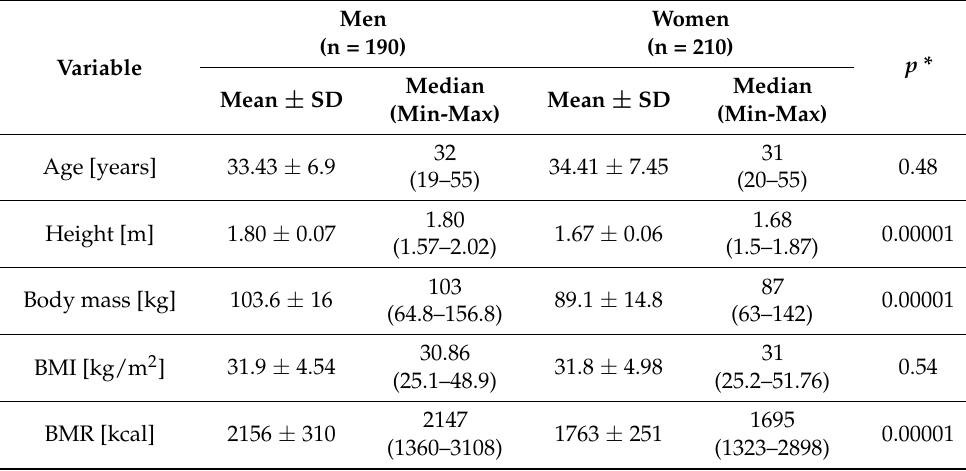
Table 3. Characteristics of women and men at the beginning of the